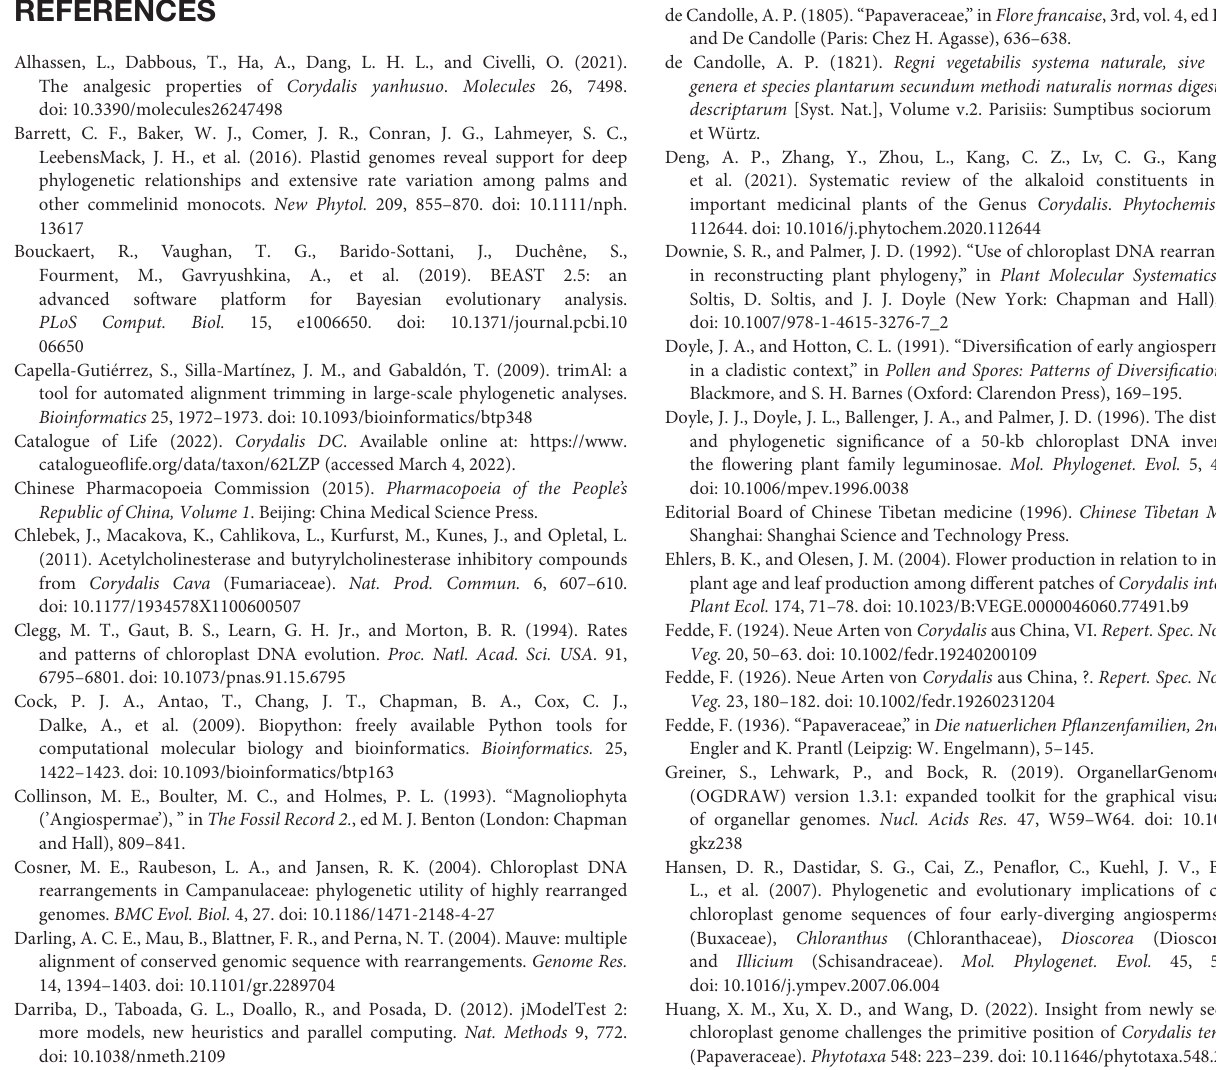
Supplementary Table 1 | Detailed information for plastome sequencing and assembling results. The column “Assembling result” indicates the numbers of scaffolds that belong to the corresponding part, LSC, IR, and SSC, respectively. For “Total length”, the length of IR was counted two times in the uncircularized